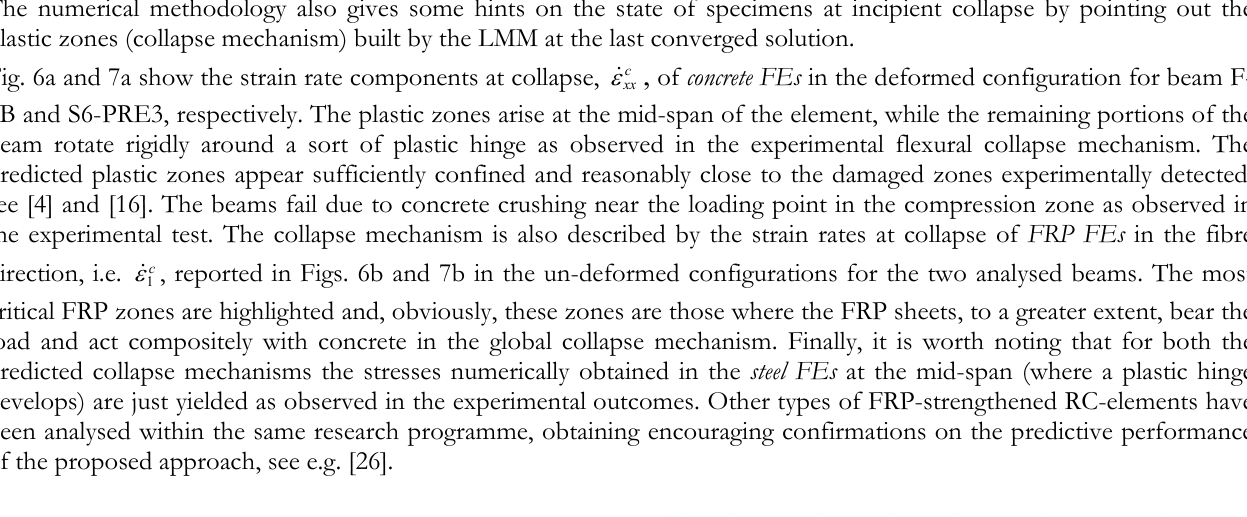
of concrete FEs reported in xx  c of FRP FEs in the fibre direction 1 